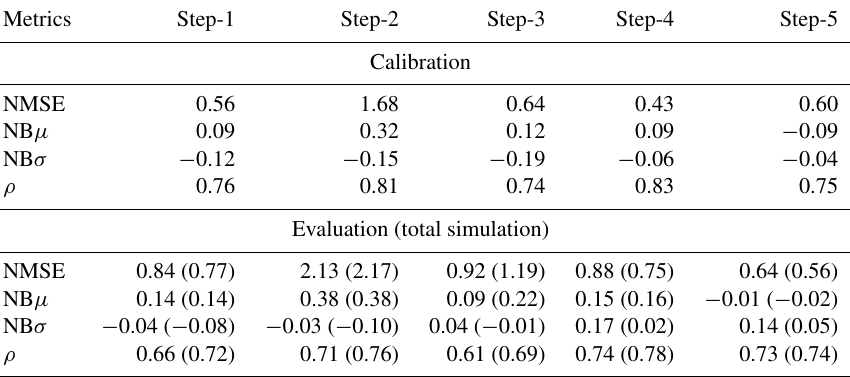
Table 5. Streamflow error statistics for calibration, evaluation, and total simulation (in parentheses) for all five different steps in Stage-I